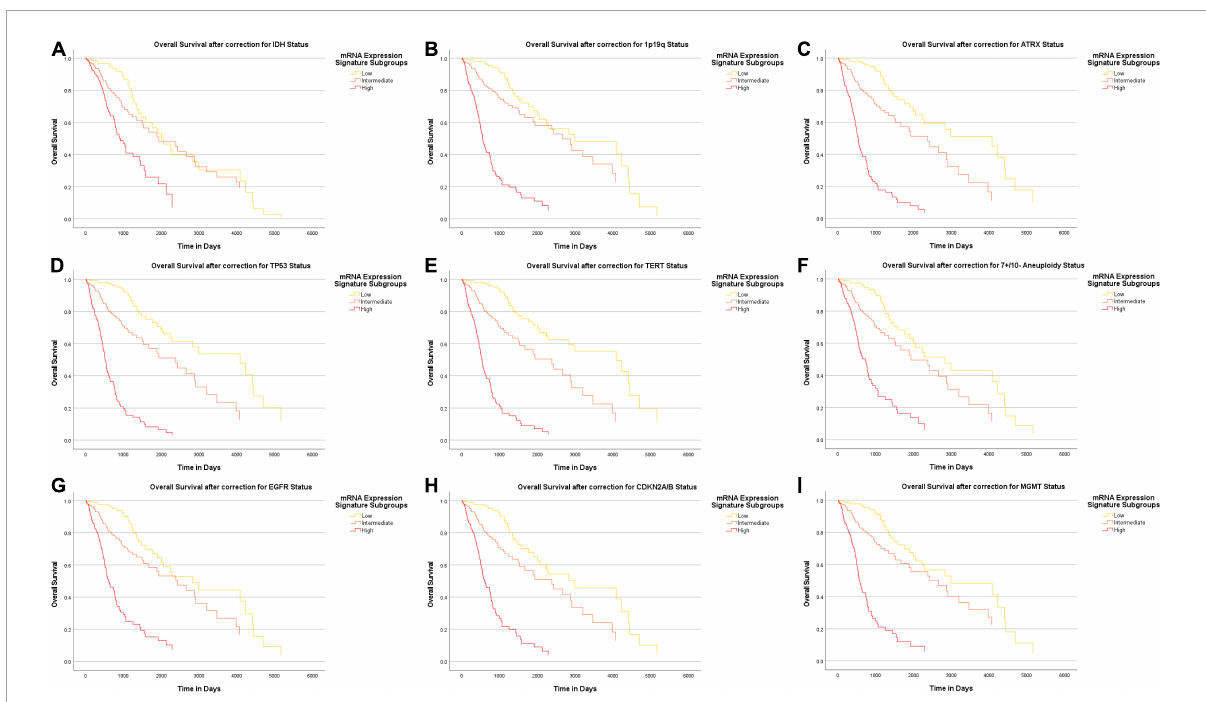
FIGURE6 Survival-curves for overall survival after correction for distinct molecular markers. Kaplan-Meier curves for overall patient survival are shown after correction for distinct molecular markers. The heme biosynthesis mRNA expression signature showed a statistically significant correlation ( p < 0.0005) with patient survival after correction for all investigated markers in separate analyses including IDH mutation status (A) , 1p19q codeletion status (B) , ATRX loss status (C) , TP53 mutation status (D) , TERT promoter mutation status (E) , 7 + /10- aneuploidy status (F) , EGFR amplification status (G) , homozygous CDKN2A/B loss status (H) and MGMT promotor methylation status (I)